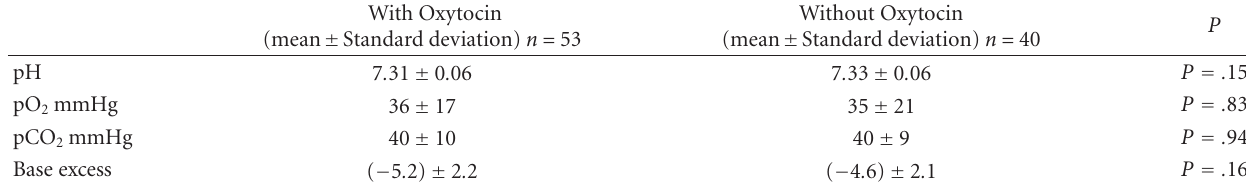
Table 2: Cord blood